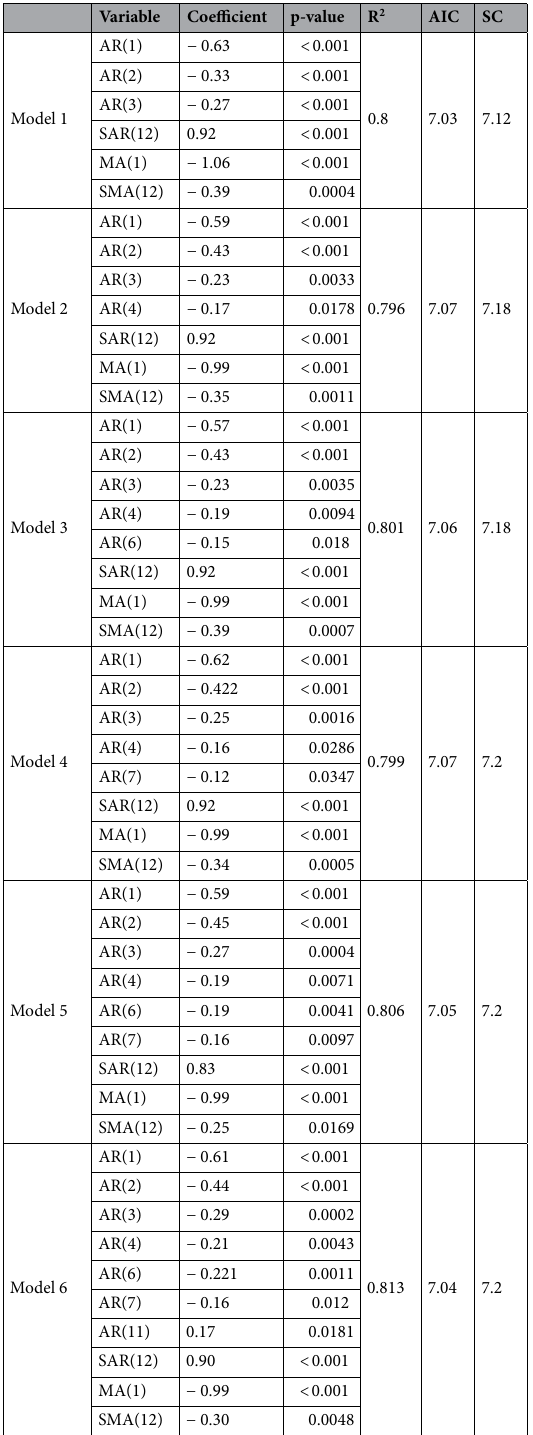
Table 2. Six models with their R 2 , AIC and SC passed parametric